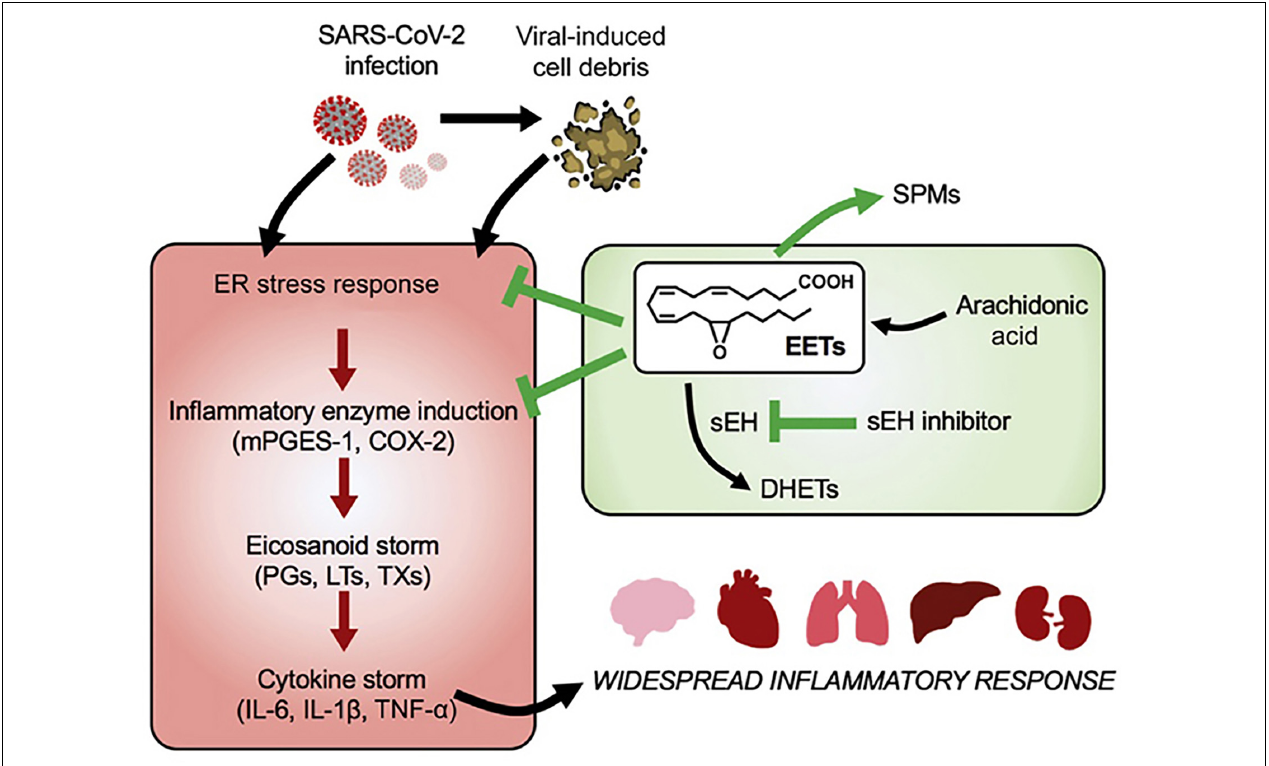
FIGURE 8 | Lipid (eicosanoid) storm may occur before the cytokine storm in SARS-CoV-2 infection. Eicosanoids are bioactive lipid mediators derived from oxygenated polyunsaturated fatty acids (PUFAs). Reprinted from Hammock et al. (2020) with permission.